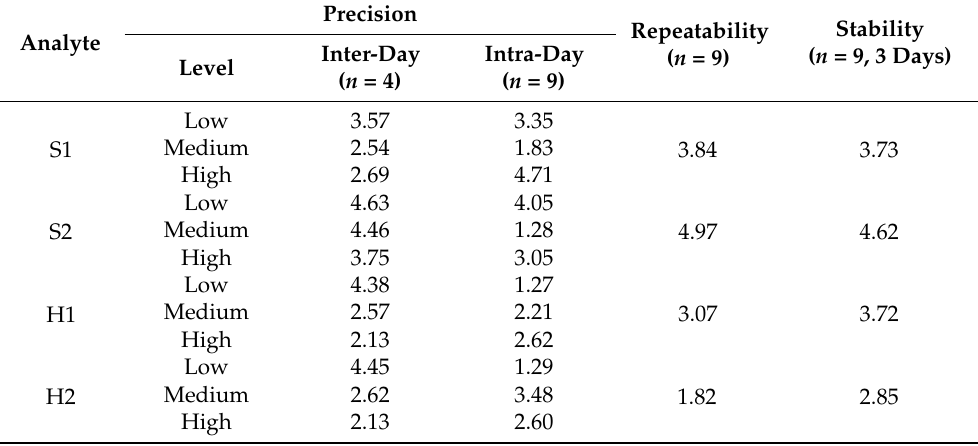
Table 2. Inter- and intra-day precision, repeatability, and stability of four analytes (RSD, %).